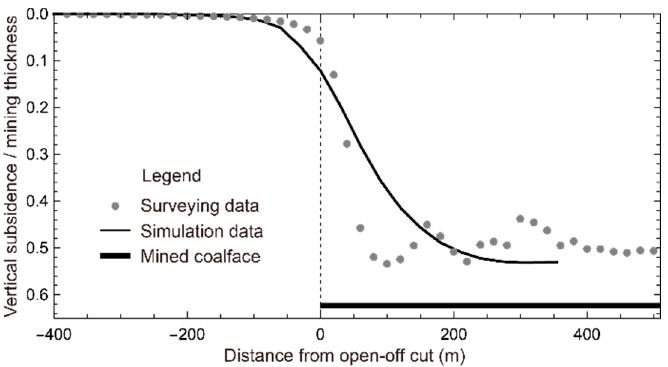
Figure 5. Comparison between the simulated vertical subsidence curve of Test 3 and the 11th field monitoring data of a coalface in Bulianta mine (both along the strike direction). Table 4. Comparison of the subsidence coefficients obtained from Test 3 and the field monitoring data.